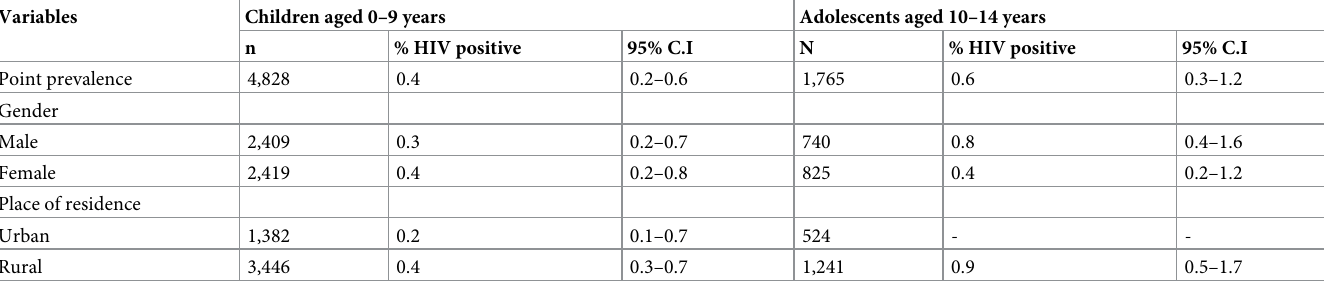
Table 2. HIV Prevalence disaggregated by place of residence and gender for children 0–9 years and adolescents 10–14 years, AKAIS 2017. Variables